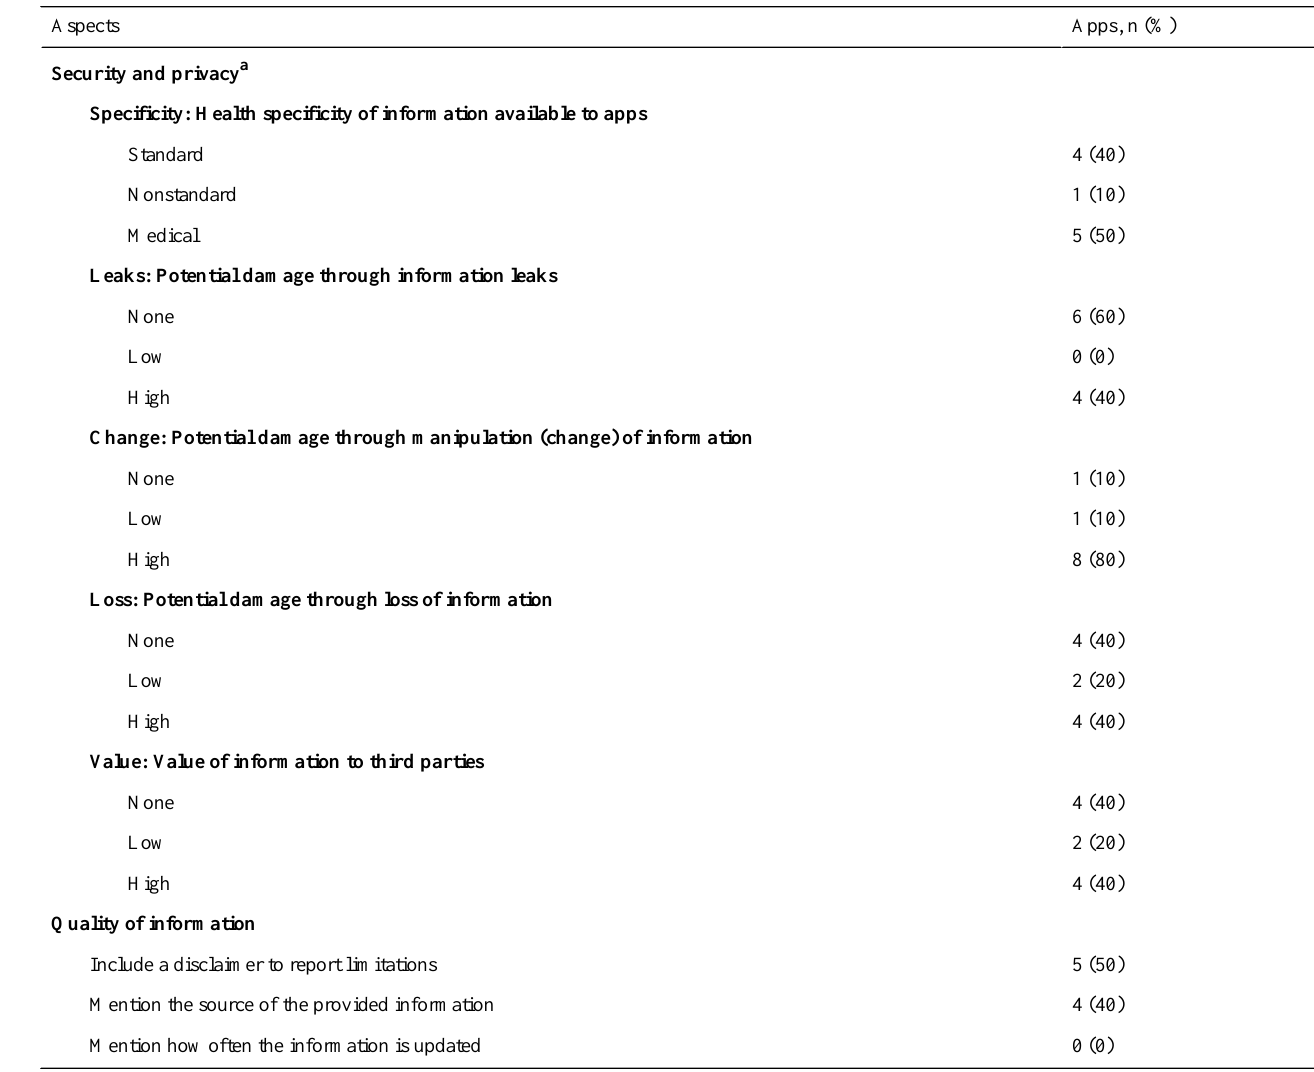
Table 3. Aspects of security, privacy, and quality of the information in the 10 most downloaded medical apps in Peru (data as of May 2019).